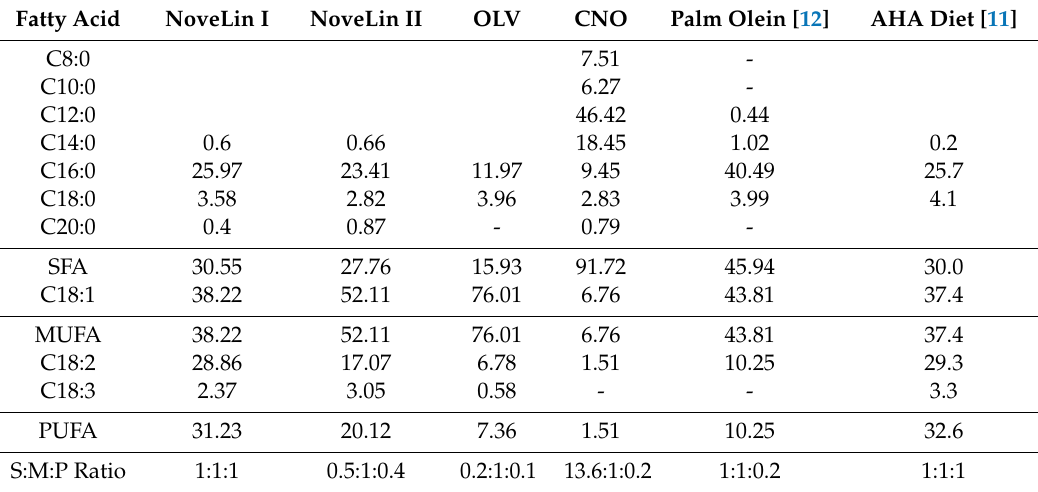
Table 1. Fatty acid composition of test